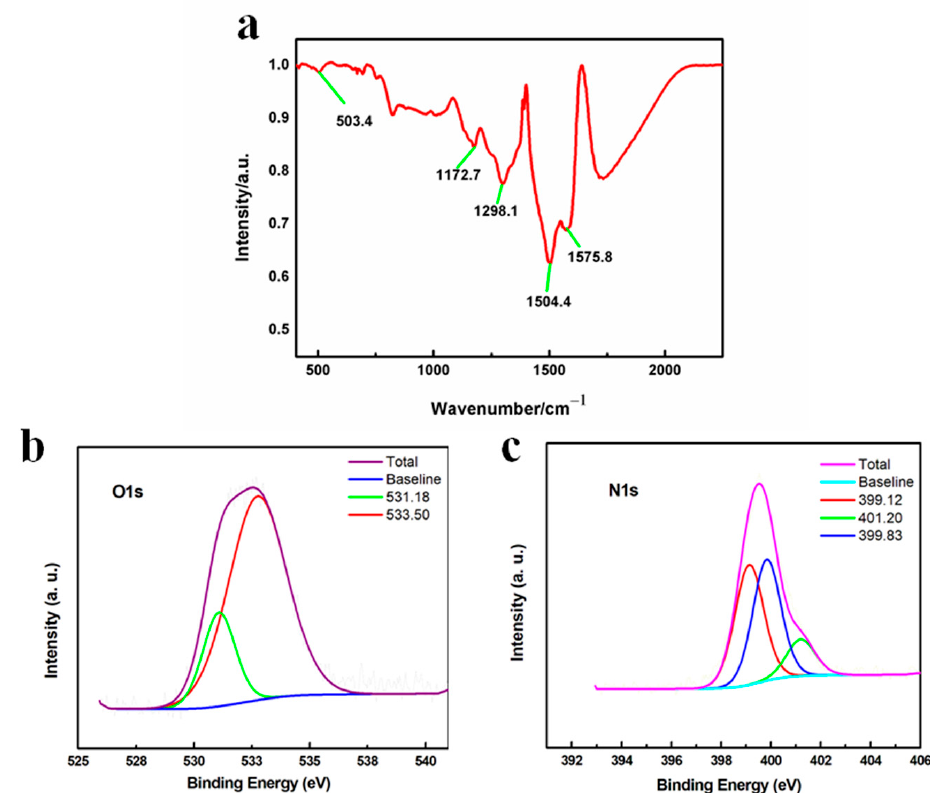
Figure 4. ( a ) FTIR spectrum of MnO 2-x /PANI; XPS spectrum of MnO 2-x /PANI ( b ) O 1s and ( c ) N 1s.